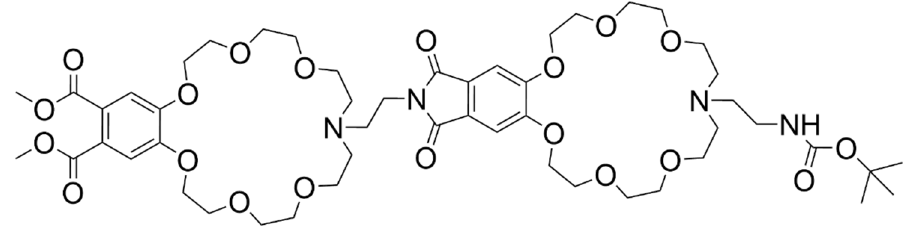
Figure 16. ( a ) Proposed structure adapted from Fokkens et al. and Monte Carlo simulations of the complexes between MPnT and Ac-Lys-OMe ( b ) and Ts-Arg-OEt ( c )—MacroModel 7.1, Amber*, water, 5000 steps. Reprinted from [24] with permission. Copyright (2005) American Chemical Society.